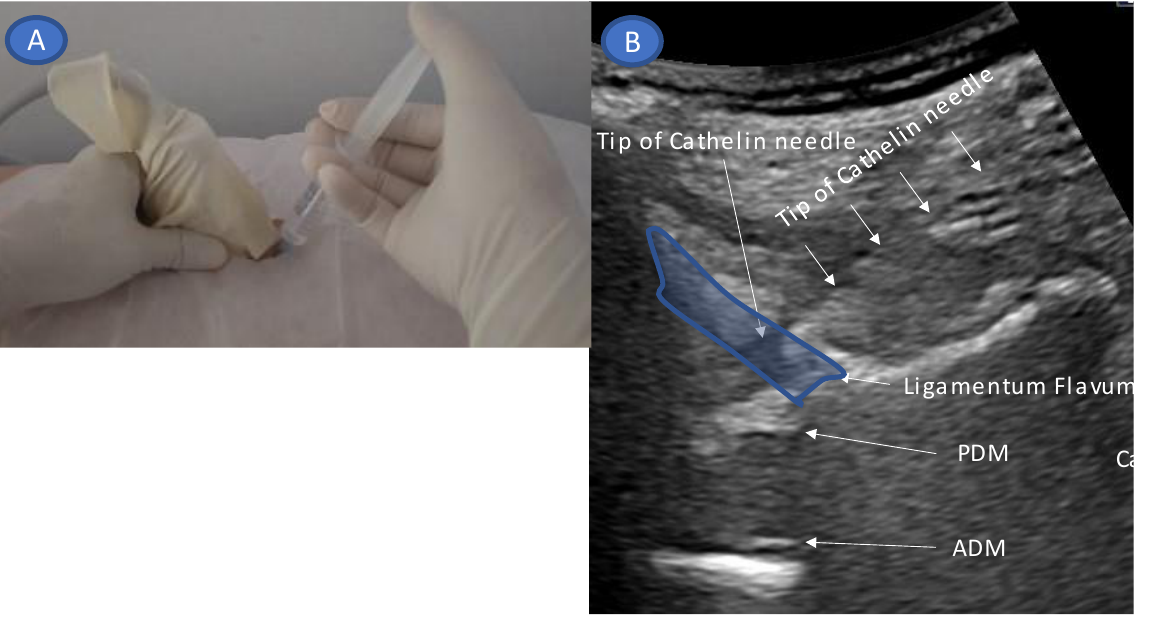
Figure 4. Needle insertion technique. Panel ( A ) shows the orientation of the transducer and the needle direction.The ligamentum flavum rupture US-guided epidural injection was performed using a 20°-rotated paramedian sagittal oblique approach. The needle tip was introduced into the lig- amentum flavum. We confirmed whether the needle tip was within the ligamentum flavum by in- jecting a small amount of fluid and ensuring that the SMI signal did not flow back to the surface of the ligament; that is, it remained within the ligament ( A ). The needle was slowly advanced close to the epidural fat layer within the ligamentum flavum as pressure was applied to the syringe. When the ligamentum flavum ruptured and the SMI signal appeared in the epidural fat layer, needle ad- vancement was stopped, and the remaining injectant ( B ) was injected. While injecting the injectant, the SMI signal was monitored in the epidural space until the drug infusion was completed. We detected SMI signals when a signal appeared in the thecal sac. Drug infusion was discontinued im- mediately, and the needle tip was repositioned. Abbreviations: SMI, superb microvascular imaging. We confirmed that the needle tip had reached the ligamentum flavum by observing the monitor and by the ligamentous resistance tactile sensation transmitted to the syringe. Once the needle tip approached the ligamentum flavum, the US was switched to SMI mode to confirm the position of the needle tip and injectant spread (Figure 5A). The sy- ringe was pressed, and the needle was slowly advanced close to the epidural fat layer within the ligamentum flavum. The needle advancement was stopped, and the remaining injectant (9 mL of 0.25% lidocaine and 4 mg dexamethasone) was injected when the liga- mentum flavum ruptured and the SMI signal appeared in the epidural fat layer (Figure 5B – F, Supplementary, Video S1). While injecting the injectant, the SMI signal was moni- tored in the epidural space until the drug infusion was completed. The infusion of the injectant was stopped immediately, and the needle tip was repositioned when a signal was detected in the thecal sac (Figure 6). If the dural canal was stenotic, cerebrospinal fluid (CSF) flow was observed as a pulsatile SMI signal (Figure 7), which can be differentiated from the steady-state SMI signal associated with the injection (Figure 8). In addition, pul- satile SMI signals appeared at inflamed sites, such as protruding discs (Figure 9).